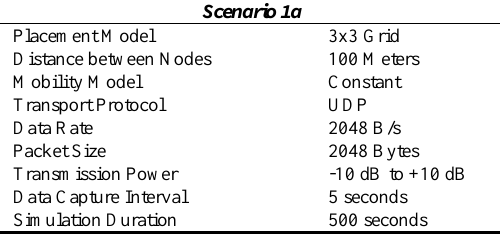
Table 6. Setting under Scenario 1a .